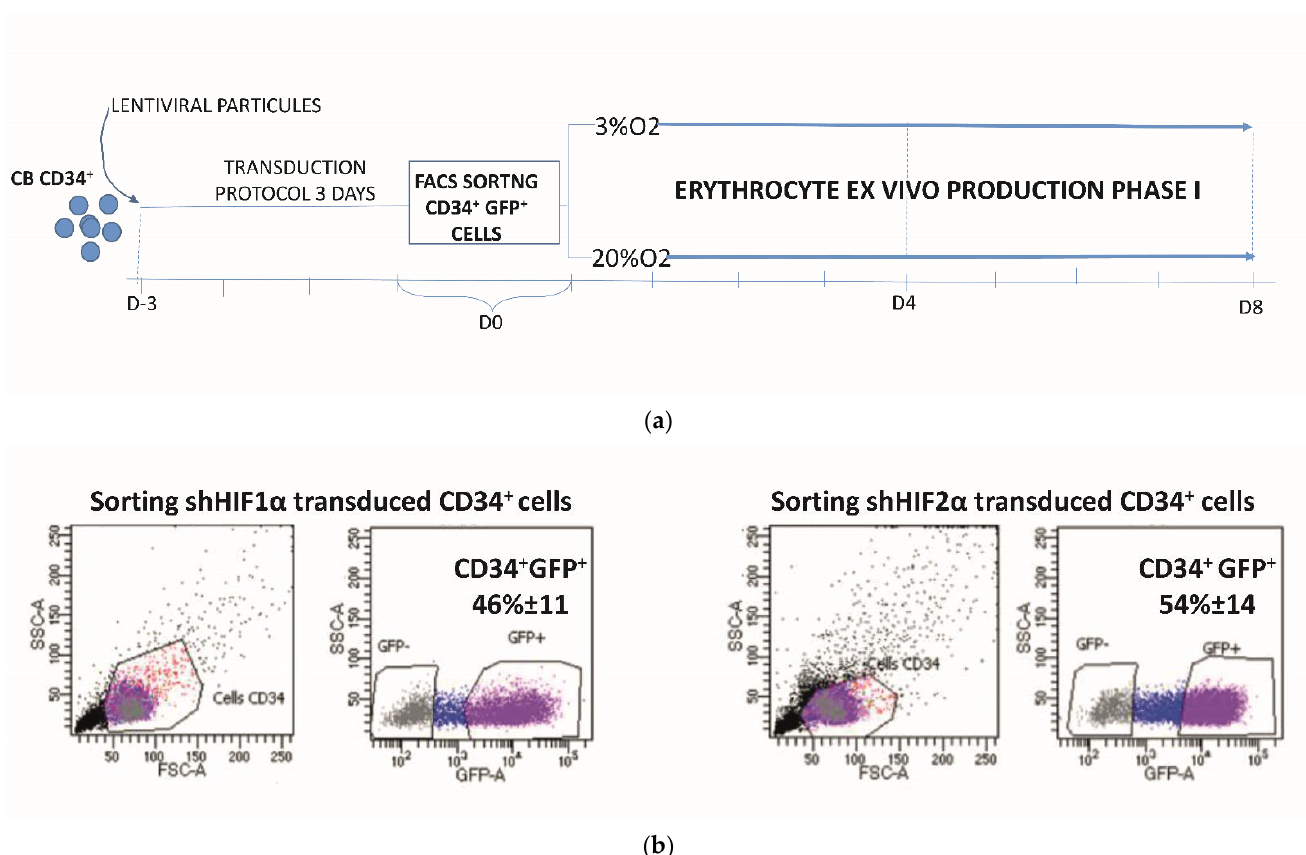
Figure 1. Experimental design. ( a ) Cord blood CD34 + cells (10 6 cell/mL) were cultured (Day 3 to Day 0) for three days and transduced with shRNA to HIF1α and shRNA to HIF2α at a concentration of 25 MOI (Multiplicity Of Infection) twice at 24 h intervals. As control, we used non-transduced cells (NT). Then, transduced cells were sorted based on Green Fluorescence Protein (GFP) expression by FACS and plated in the erythroid culture protocol for 8 days (Day 0 to Day 8). Non-transduced CD34 + cells in presence or absence of Notch γ -secretase inhibitor DAPT as well as transduced CD34 + cells with shHIF1α or with shHIF2α were grown in erythroid medium for 8 days at 20% and at 3% O 2 . At selected time points, cells were stained with antibodies for flow cytometry or immunofluorescence, assayed for their CFC content, underwent CFSE staining or were proposed for real-time polymerase chain reaction (PCR) as described in materials and methods. ( b ) The representative dot plot showing FACS sorting based on GFP expression giving the transduction efficiency of lentiviral particles containing shHIF1 and shHIF2 in CD34 +